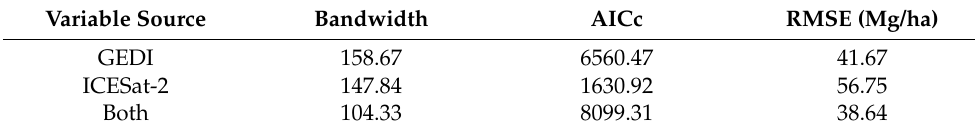
Table 8. The comparison among GWR models based on three data